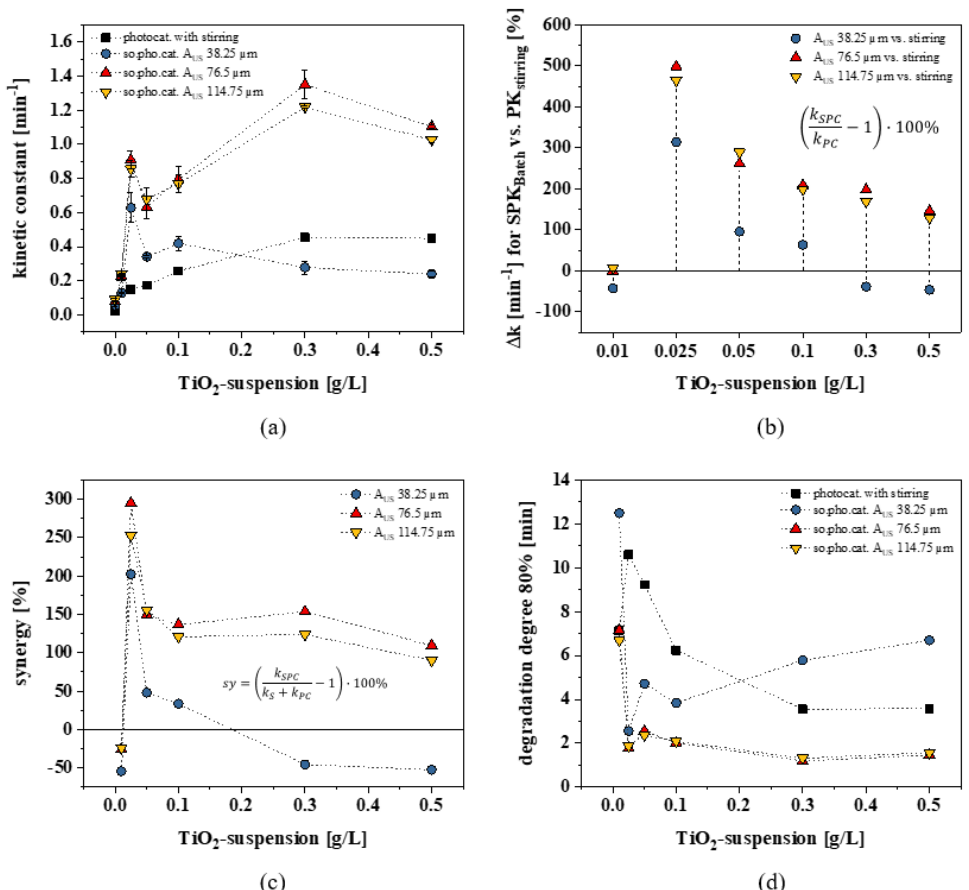
Figure 5. Sonophotocatalytic degradation compared to the stirred photocatalysis for the amplitudes 38.25, 76.5, and 114.75 µm and TiO 2 dosages 0.01–0.5 g/L. ( a ) Absolute degradation rates; ( b ) difference between photocatalytic and sonophotocatalytic degradation; ( c ) synergistic values; and ( d ) degradation time for 80% degradation degree.